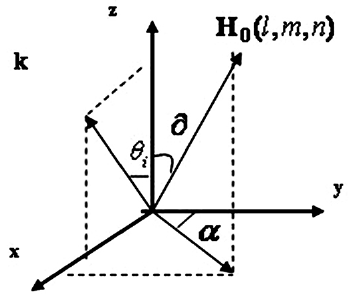
Figure 1. The Cartesian coordinate system ( k indicates the incident electromagnetic wave at X – Z plane; H 0 is the Earth’s magnetic